Question: Briefly state, in one sentence, what is plotted here.
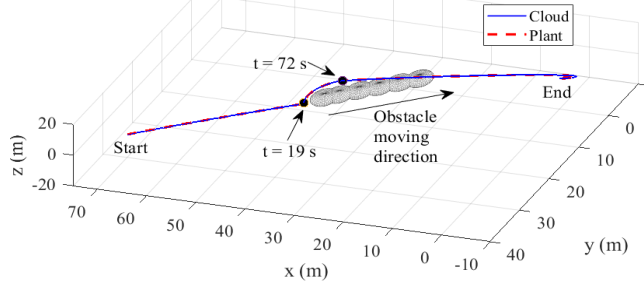
Answer: Comparison of obtained trajectory in 3D space